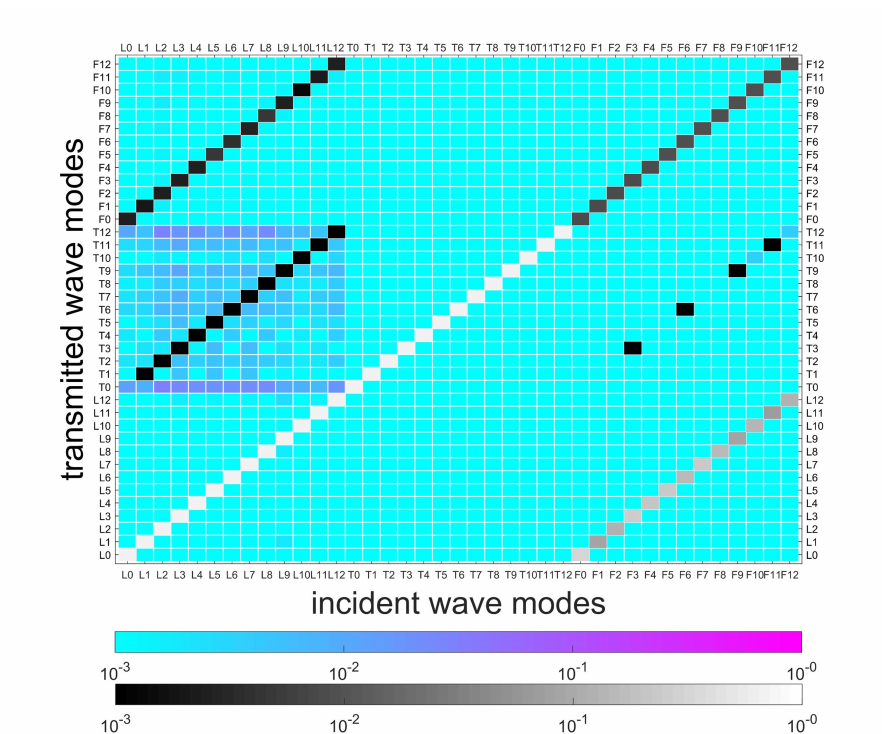
Figure 13. Transmitted waves of coupling element with damage (10% Young’s modulus loss in 15 ◦ ). The marked conversions in Figure 12 are caused by both the flange and damage in this case. Hence, they are painted by a gray color-bar to distinguish them from wave-mode conversion induced by damage.